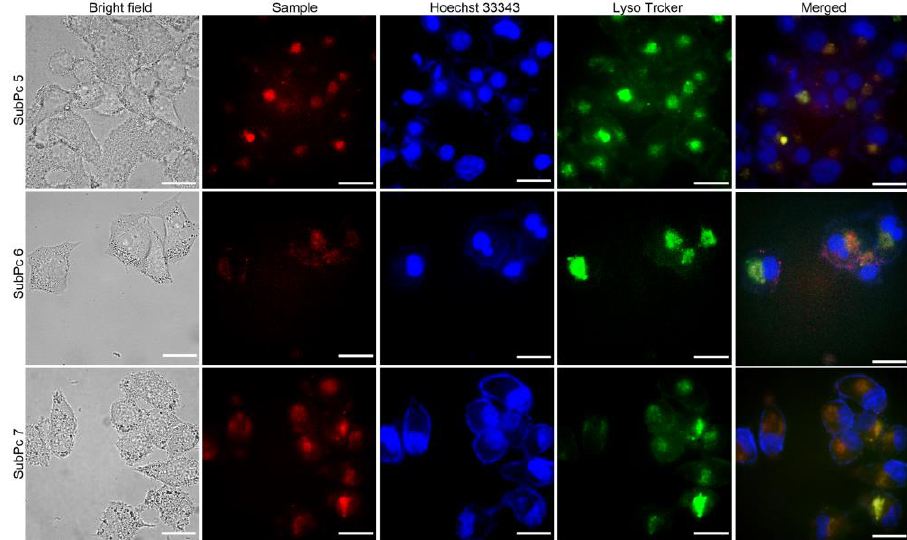
Figure 5. Visualization of the intracellular fluorescence of SubPc 5 – 7 (after incubation for 4 h) and various subcellular trackers in HeLa cells. The corresponding bright-field and merged images are given in rows 1 and 5, respectively. The figures in rows 2 show the fluorescence intensity profiles of 5 – 7 and the corresponding images of Hoechst 33342 and Lyso Tracker Green DND-26 in rows 3 and 4, respectively. Scale bar: 5 μm.